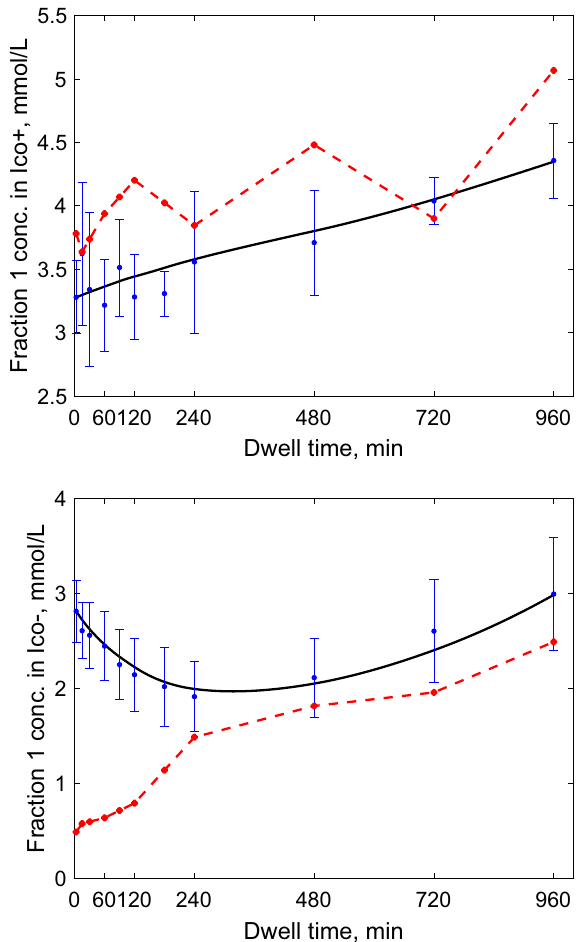
Figure 6. Concentration of LMW icodextrin oligomers (fraction 1) in dialysate during 16-h peritoneal dialysis with 7.5% icodextrin: clinical data for Ico+ (upper panel) and Ico− (bottom panel) group in dialysate expressed as mean ± SD (blue dots) and in plasma as mean (red stars, dashed line) and the mean predicted profile by the extended three-pore model (black solid